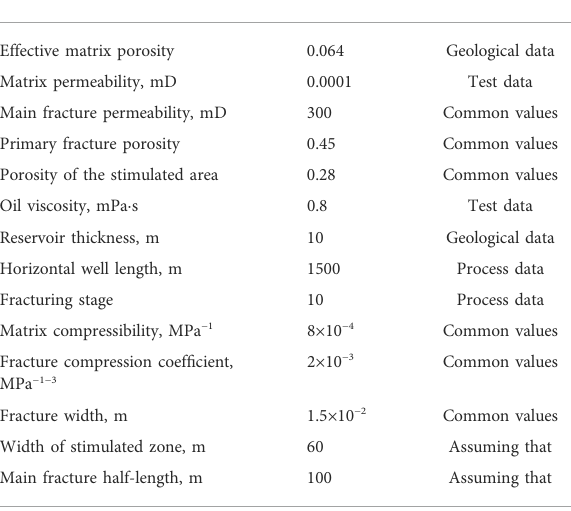
TABLE 1 Basic parameters of the Gulong shale closed-well numerical